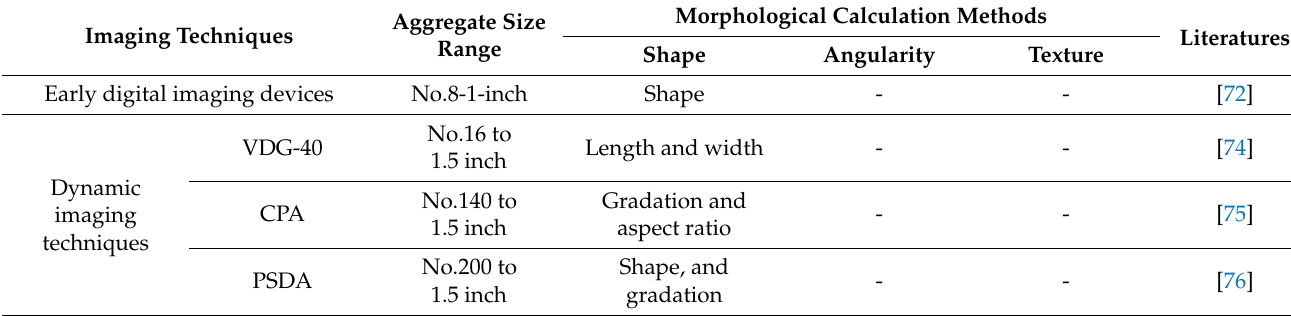
Table 4. Characteristics of different imaging